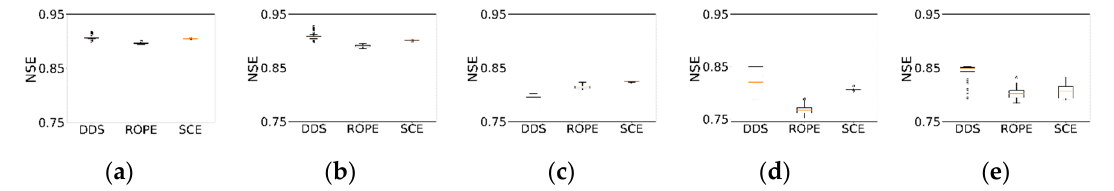
Figure 10. Comparison of the NSE measures developed from 100 sets of randomly selected initial parameters for the three optimization algorithms across the five calibration stations (( a ) Station 1002640, ( b ) Station 1003630, ( c ) Station 1011690, ( d ) Station 1303680 and ( e ) Station 3009650).